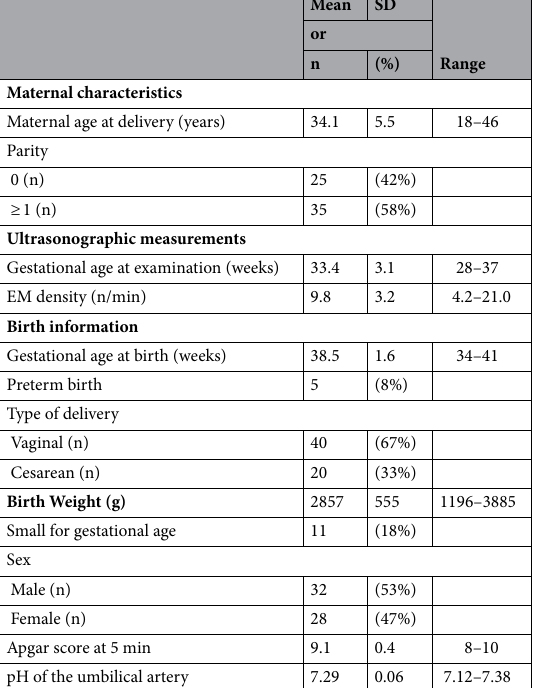
No. of outcome Univariate model Multivariate No. of answers